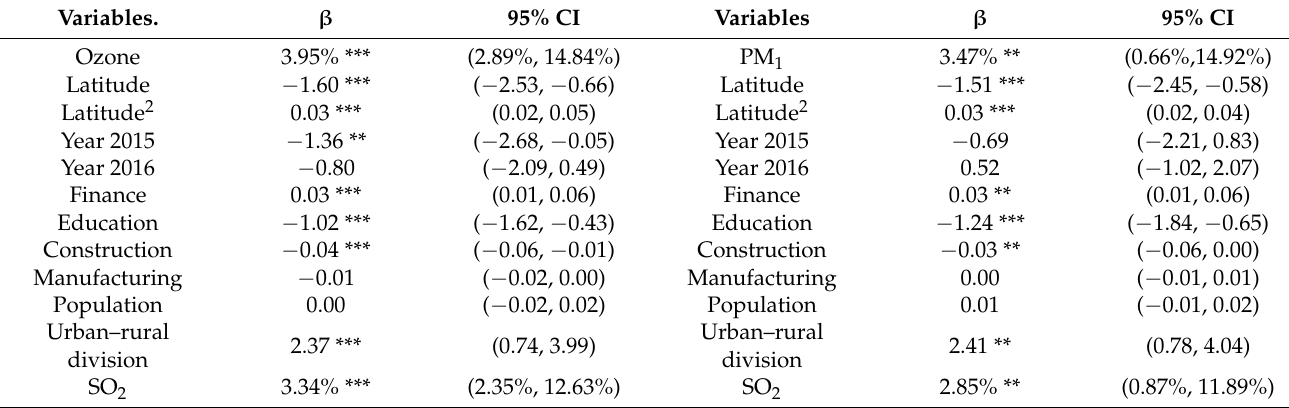
Table 4. Sensitivity analyses of ozone and PM 1 effects to the control of the additional air pollutant (i.e., SO 2 ).